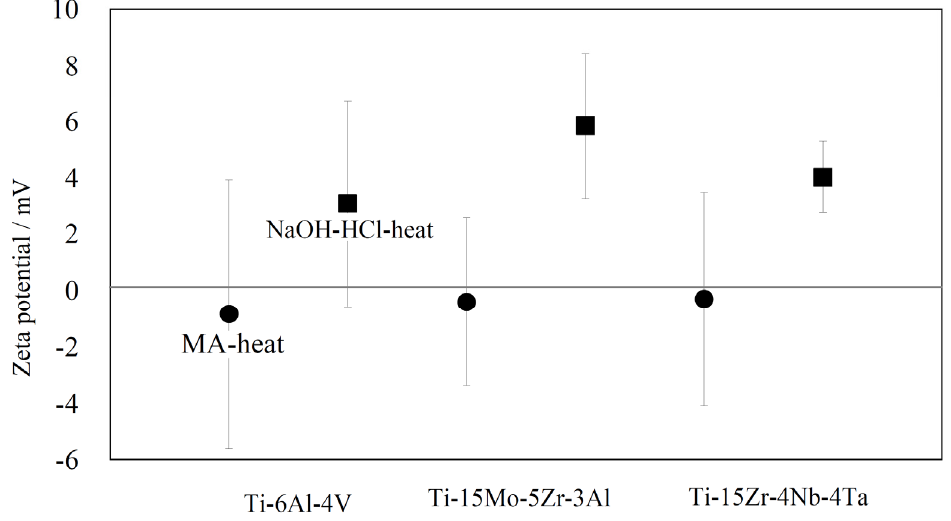
Figure 4. Zeta potential of Ti alloys subjected to MA-heat treatment (black circle) or NaOH-HCl-heat treatment (black square).